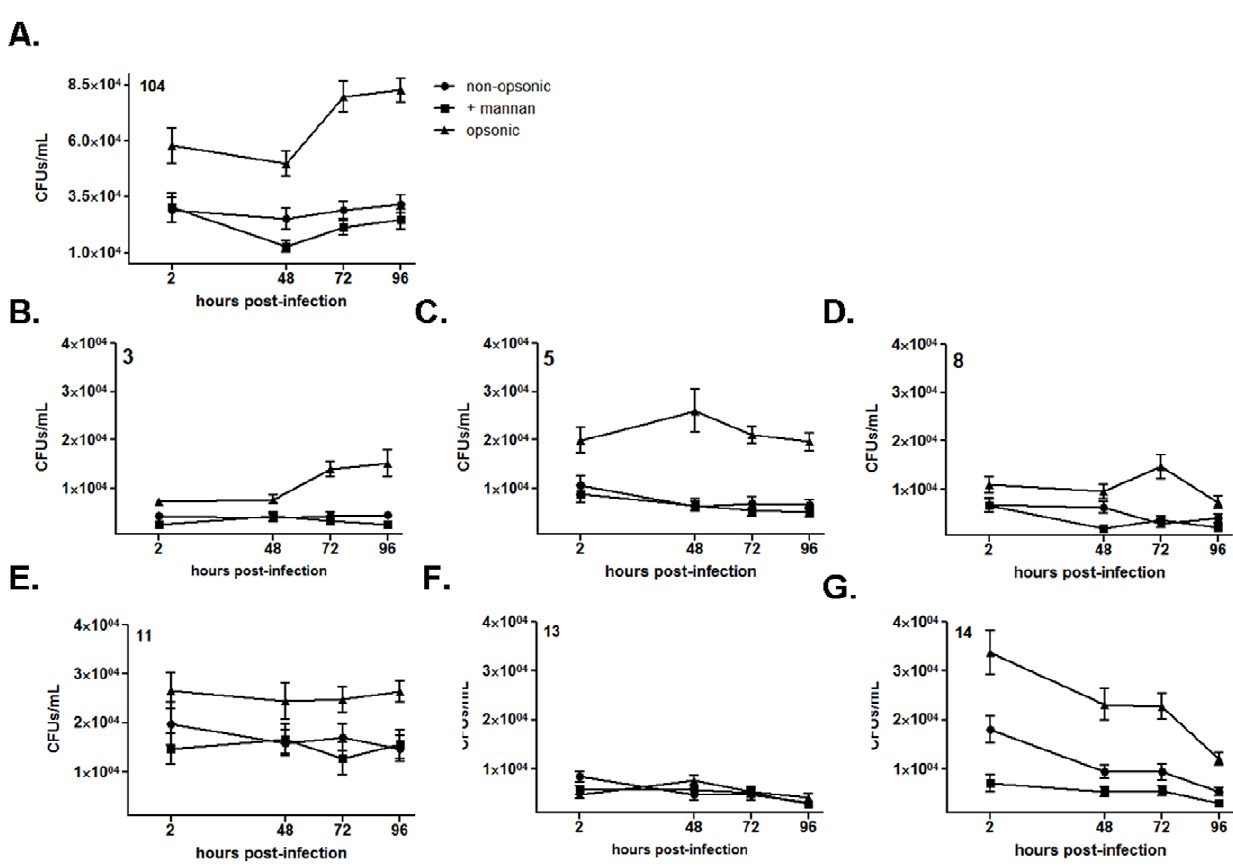
Figure 7. Growth of M.avium spp. isolates in human macrophages. Macrophage monolayers (2.0 6 10 5 cells/well) plated in triplicate in cell culture plate wells were incubated with isolates (MOI 5:1) for 2 h at 37 u C, 5% CO 2 . Survival curves (CFUs) for MAC reference isolate 104 Ser. 1 ( A ), isolate 3 Ser. 9 ( B ), isolate 5 Ser. 4 ( C ), isolate 8 Ser. 9 ( D ), isolate 11 Ser. 8 ( E ), isolate 13 Ser. 4 ( F ) and isolate 14 Ser. 8 ( G ) are shown. Infection conditions used were: non-opsonic (round symbol); non-opsonic in the presence of mannan (2.5 mg/ml) (square symbol); and opsonic condition in the presence of 10% fresh autologous non-immune serum (triangle symbol). Note that the vertical axis in panel A differs from the other panels. Shown are cumulative data from N=3 (mean 6 SEM).